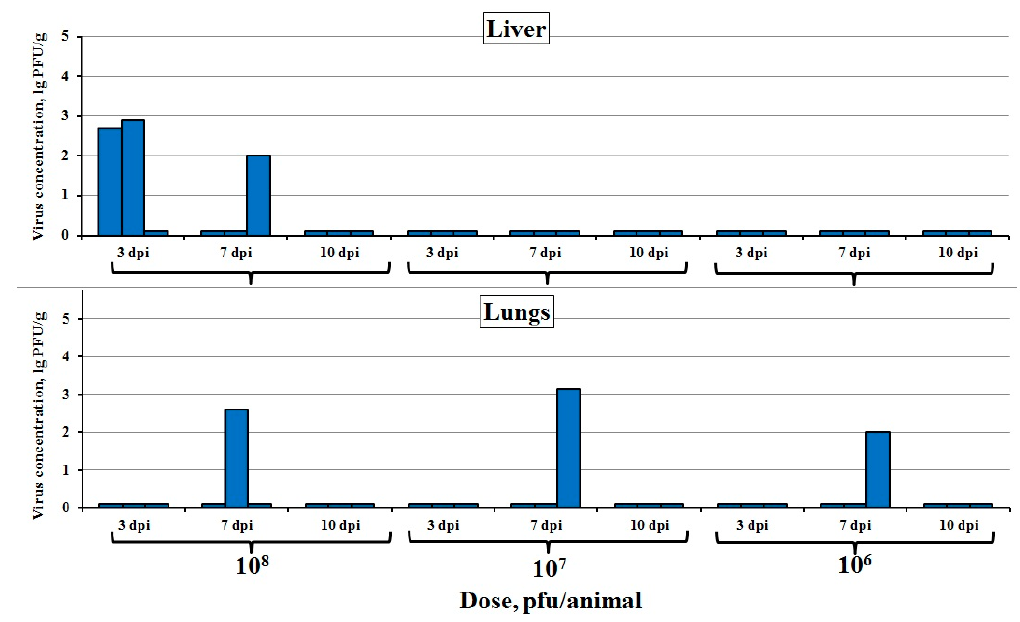
Figure 3. VACV concentration in the internal organs of mice intradermally infected with the LIVP-14 strain at doses of 10 6 , 10 7 , and 10 8 pfu. The data for individual animals on days 3, 7, and 10 post-inoculation (dpi) are presented. Organs of three mice were analyzed at each time point.